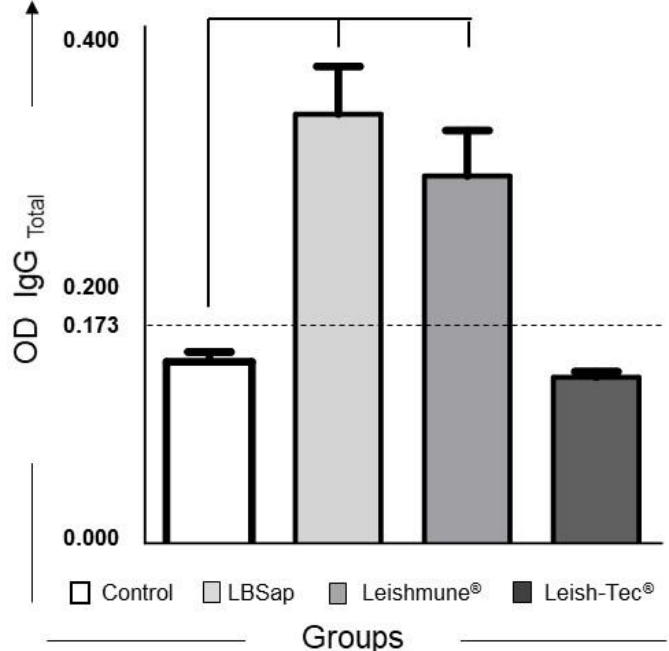
Figure 1. Anti- Leishmania total IgG reactivity in serum from dogs submitted to different vaccination protocols by immunoenzymatic assay (EIE ® —Bio-Manguinhos ® ). The x -axis displays the vaccine groups: C (control; ); LBSap (killed L. braziliensis vaccine plus saponin; ); Leishmune ® ( ); Leish-Tec ® ( ). The y -axis represents the mean ELISA absorbance values determined at 450 nm in serum samples for total IgG. The cut-off is represented by the dotted line. Significant differences ( p < 0.05) between the C group and the LBSap, Leishmune ® , and Leish-Tec ® groups are indicated by connecting lines.